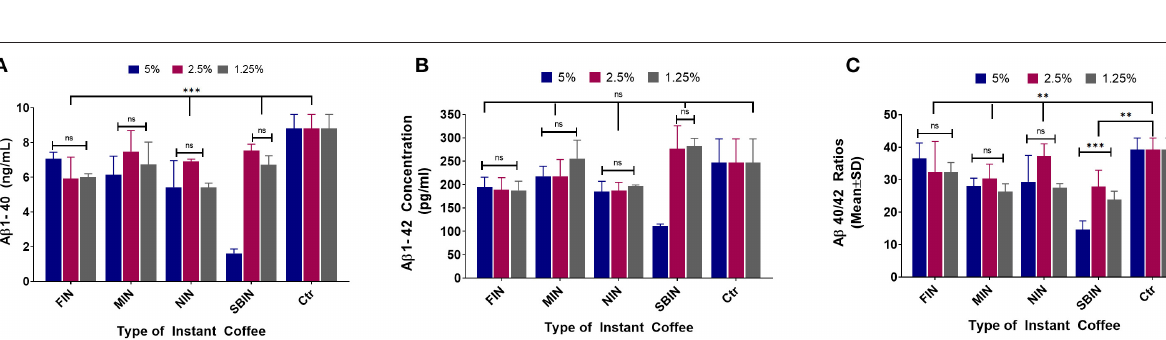
FIGURE 3 | A β 1-40 (A) , A β 1-42 (B) , and A β 40-42 ratio (C) sandwich ELISA assay results of N2a/APPswe cells treated with 4 different commercial coffees ( N = 4). In the N2a/APPswe cell lines, all commercial coffees had the ability of decreasing A β 1-40 levels among all concentrations tested (*** p < 0.001), without significant differences in concentration ( p > 0.05) (A) . Regarding the A β 1-42 levels for each commercial coffee, DC decreased A β 1-42 levels among all tested concentrations (*** p < 0.001), with the 5% concentration showing greater effectiveness than the 2.5% ( p < 0.05) (B) . Regarding the A β 40/42 ratio changes post-treatment, DC 2.5 and 1.25% concentrations had significantly lower A β 1-40/1-42 ratios (*** p < 0.001 and * p < 0.05) between all 4 coffees, no significant differences were noted between the concentrations ( p > 0.05) (C) .